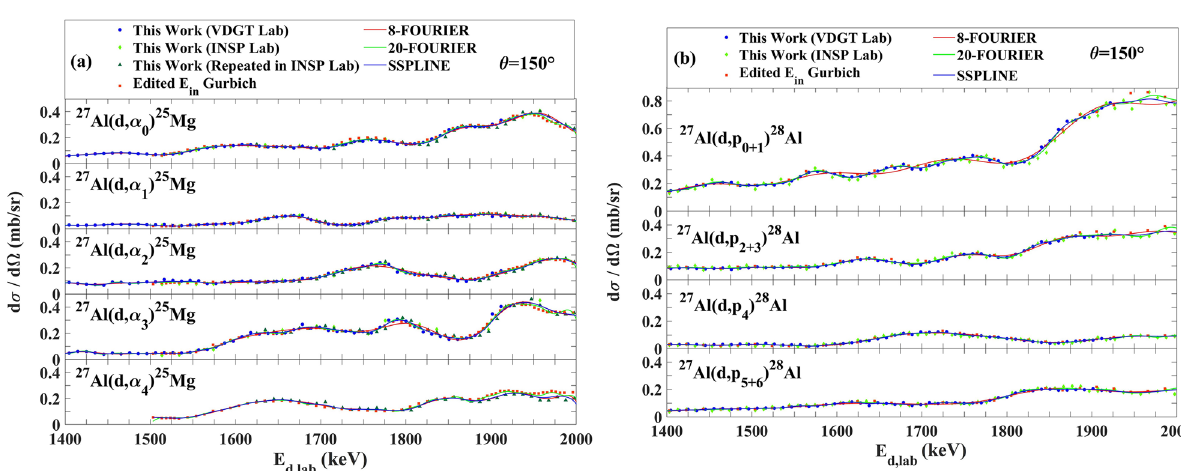
Figure 12. The comparison of different fitting methods for cross sections at 150° for ( a ) 27 Al(d, α 0,1,2,3,4 ) 25 Mg and ( b ) 27 Al(d,p 0+1,2+3,4,5+6 ) 28 Al reactions.